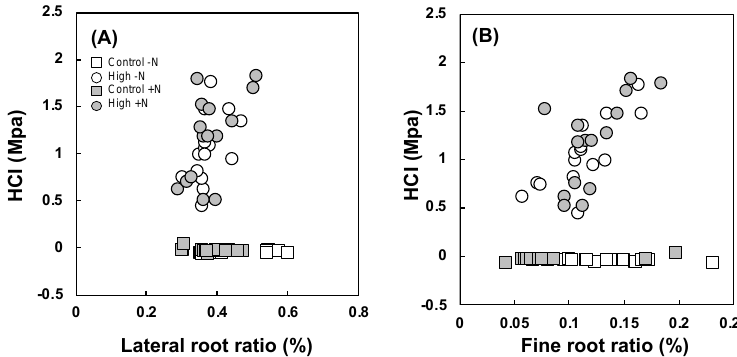
Figure 2. Relationships between ( A ) lateral root proportion and ( B ) fine root proportion and HCI ( n = 5). Circle: control; square: high compaction; white: no N loading (−N); gray: N loading (+N).